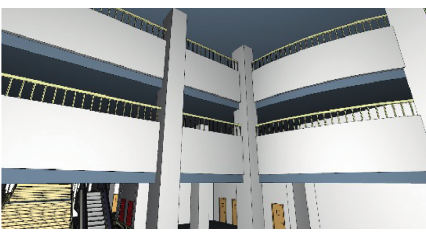
Figure 23: Hall model drawing of floor 1.